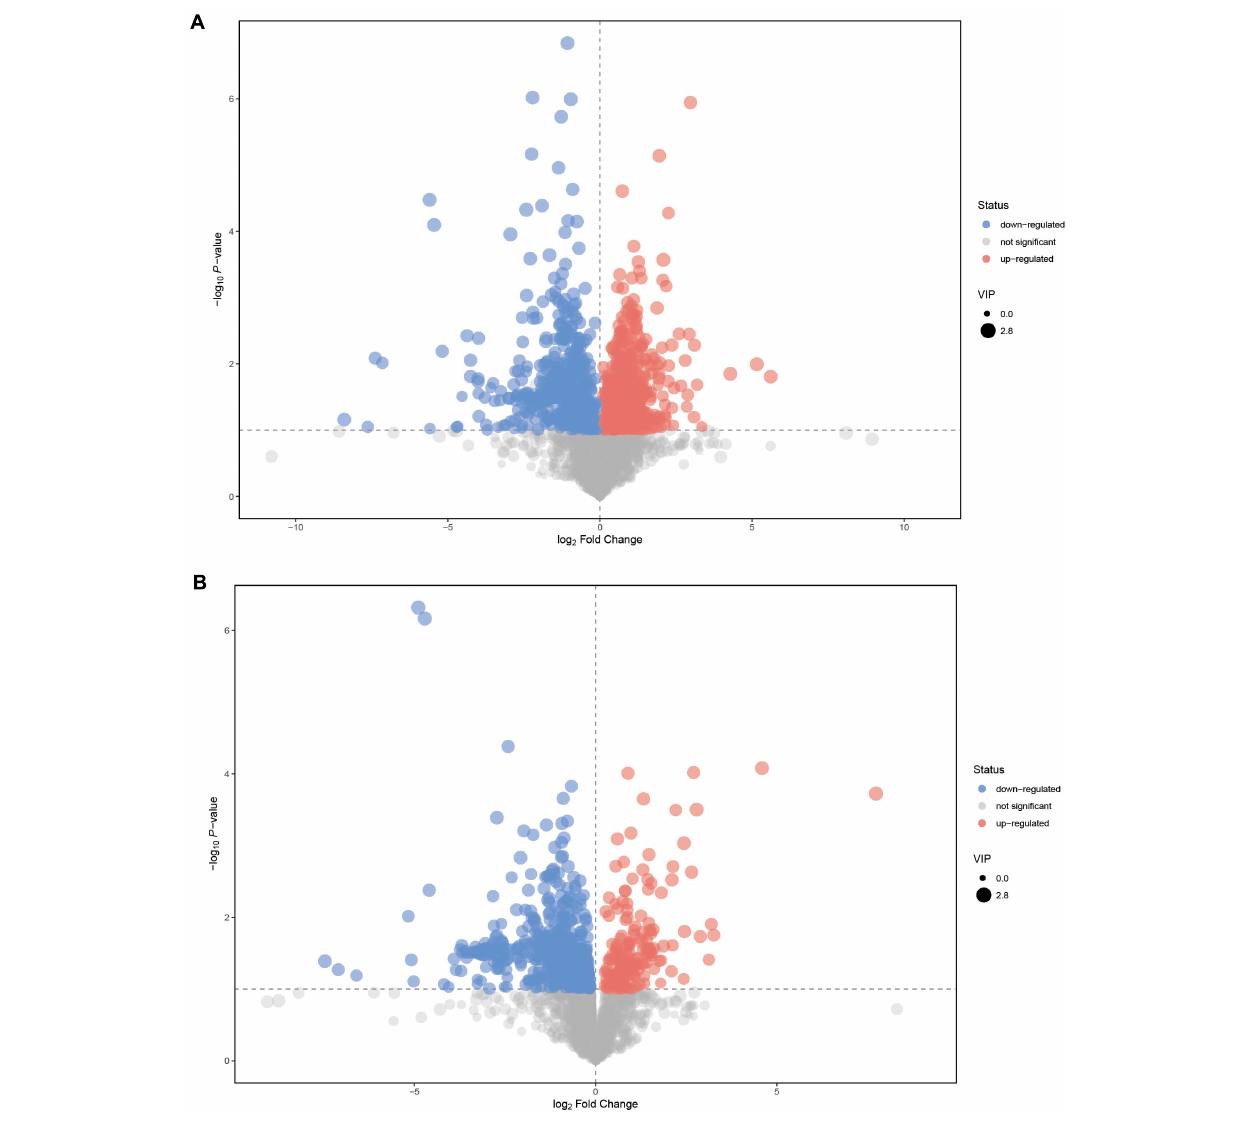
FIGURE 2 | Volcano plots for groups EG2 and EG5. (A,B) were derived from POS and NEG, respectively. In the volcano plot, each point represents a metabolite, and the point size represents the VIP value of this metabolite in the OPLS–DA model. Red, blue, and gray indicate a significantly up-regulated metabolite in EG2, the opposite, and no significant difference between the two groups,